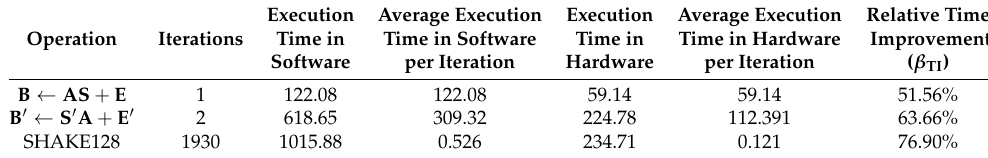
Table 4. Execution time analysis, in ms.